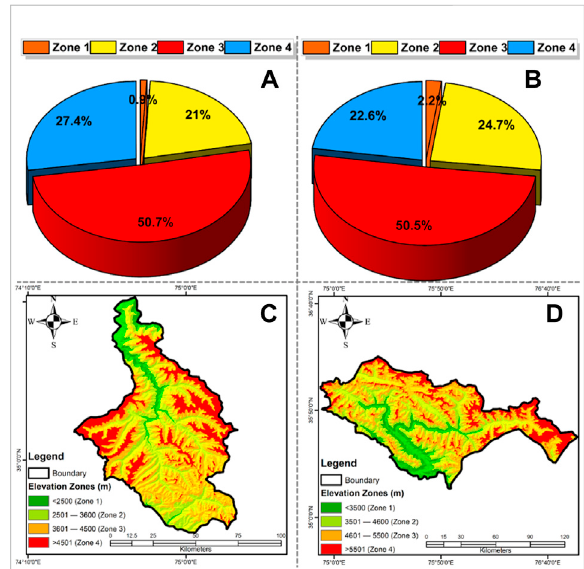
FIGURE 5 Elevation-zone wise mean SCA (1991 – 2021) of (A) Astore, (B) Shigar, (C) Astore elevation zones, (D) Shigar elevation